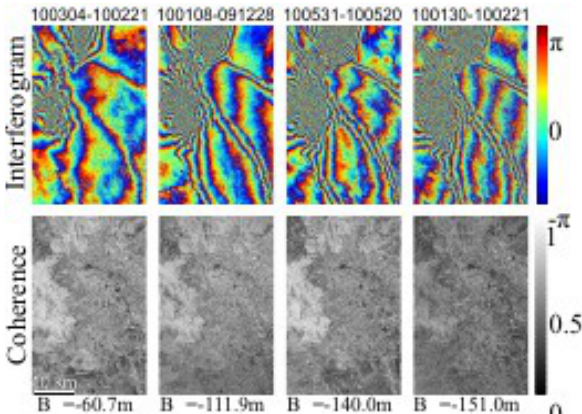
Figure 5 : Residuals are shown through a,b, and c, while the misfit is shown in d,e and f. For DEM a nalysis we did not utilize a surface reconstruction or use any global iterations. performs better over mountainous areas highlighted in b.